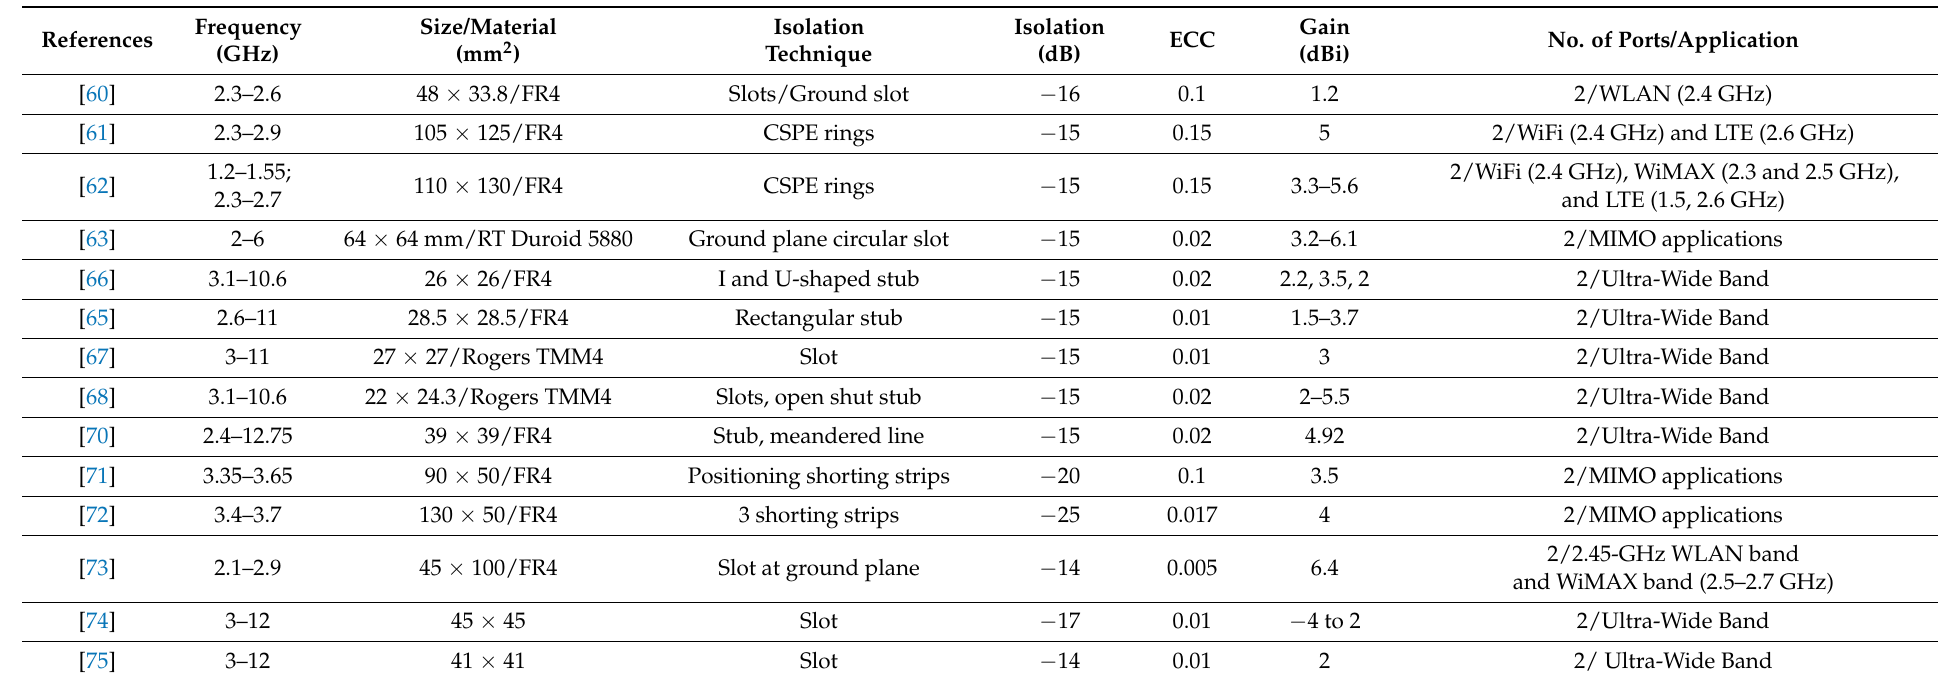
Table 2. Shared radiator antenna with two